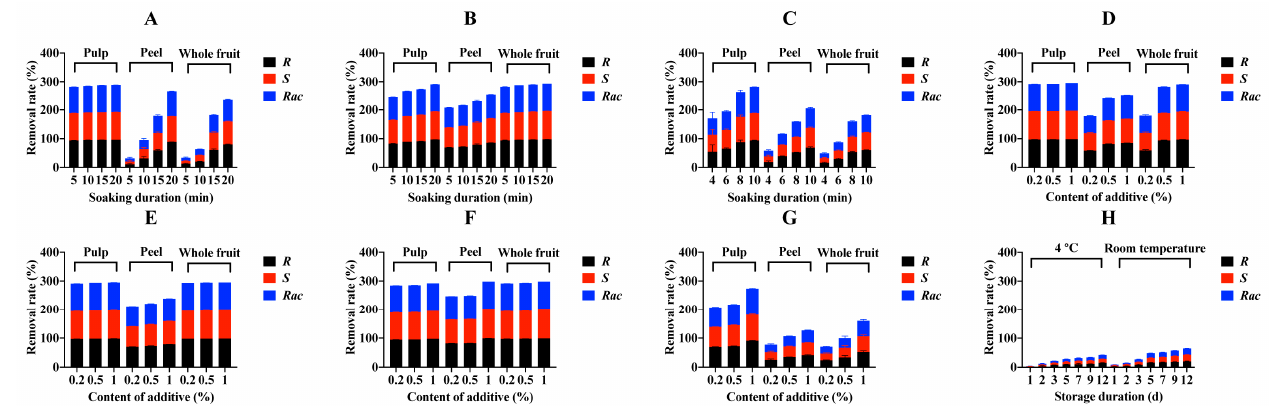
Figure 2. Rates of different soaking methods (( A ): water soaking and peeling; ( B ): heated water soaking and peeling; ( C ): ultrasound-assisted soaking and peeling; ( D ): water soaking with NaCl and peeling; ( E ): water soaking with AA and peeling; ( F ): water soaking with LAS and peeling; ( G ): water soaking with EA and peeling) and storing process at 4 °C and room temperature for different durations after juicing ( H ) to remove penthiopyrad enantiomers from cucumber samples. In Tables 3 and 4, PF values of water soaking with 1% NaCl, 1% AA, 1% LAS, and 1% EA are 0.03, 0.01–0.02, 0.01, and 0.46–0.47 for whole fruit cucumber samples. Compared to the data in water soaking without additive (PF values of 0.39–0.40), NaCl, AA, and LAS significantly improved the relief ability of water soaking and EA inhibited that ability. In summary, peeling and soaking can remove penthiopyrad residues from tomatoes and cucumbers, and temperature and the addition of chemicals can significantly affect the removal efficiency of